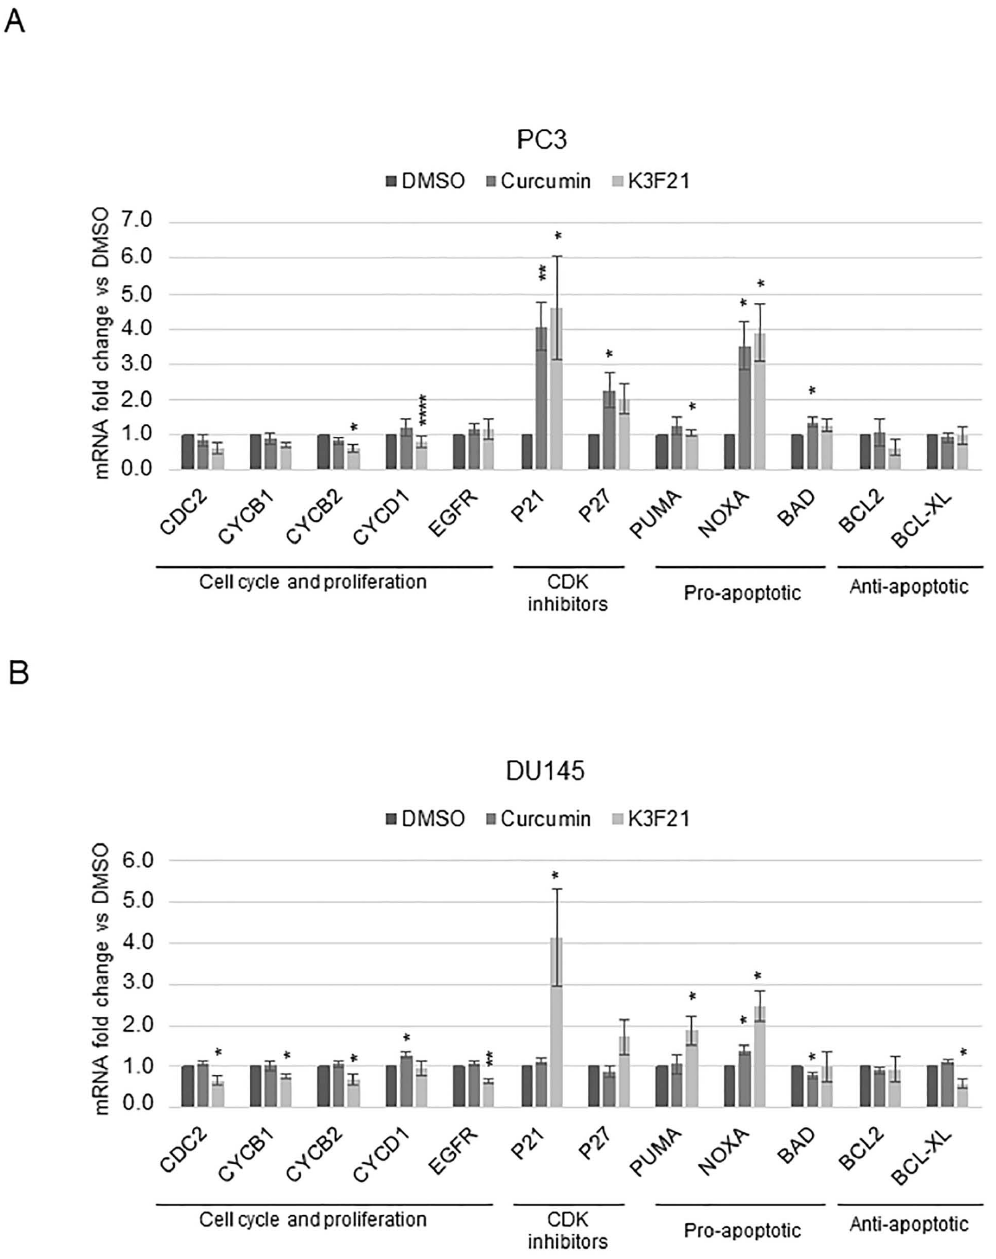
Figure 5. Effect of curcumin and K3F21 on gene transcription. RT-qPCR on PC3 ( A ) and DU145 ( B ) prostate cancer cells treated with DMSO, curcumin and K3F21 for 48 h at GI50 doses. Data are presented as relative transcript levels, normalized with RPL21 housekeeping gene, with DMSO levels arbitrarily set at 1. The bars represent the means of three independent experiments ± SEM. p values refer to the comparison between curcumin and K3F21 with DMSO samples: * < 0.05, ** < 0.01, **** <